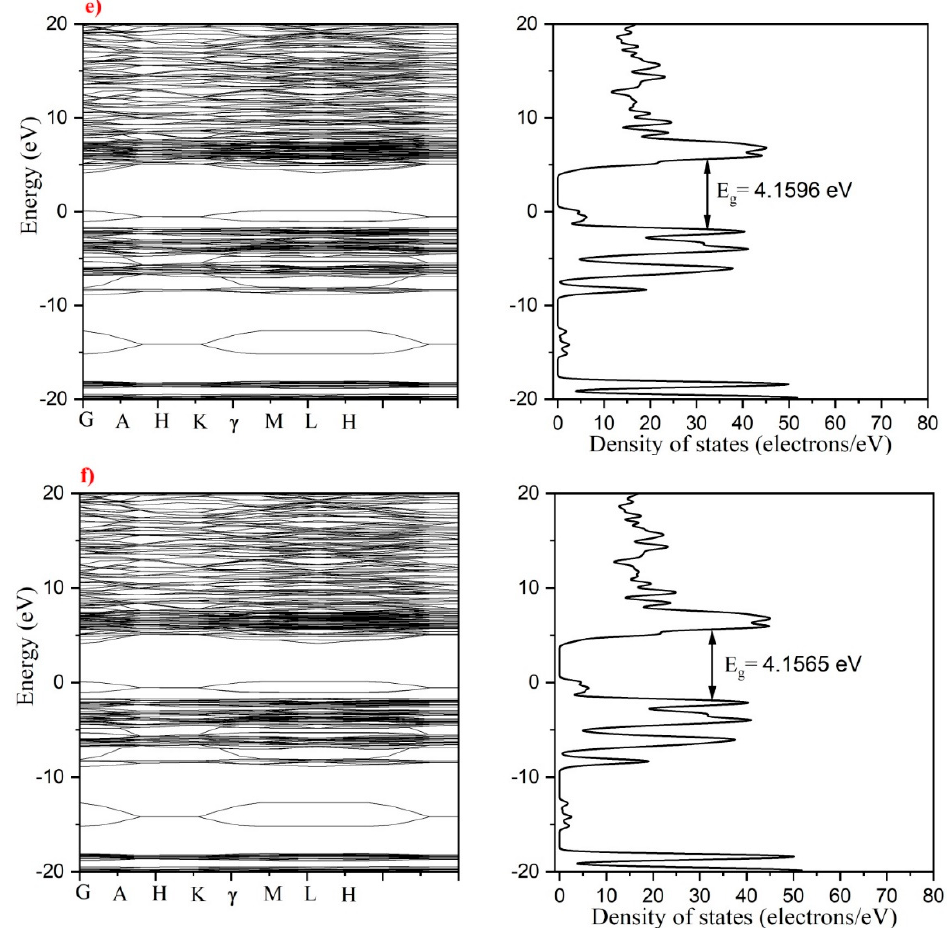
Figure 11. Band structure and density of states for ( a ) 0.13Y0.39Er/HAp, ( b ) 0.26Y0.39Er/HAp, ( c ) 0.39Y0.39Er/HAp, ( d ) 0.52Y0.39Er/HAp, ( e ) 0.65Y0.39Er/HAp, and, ( f ) 0.78Y0.39Er/HAp.